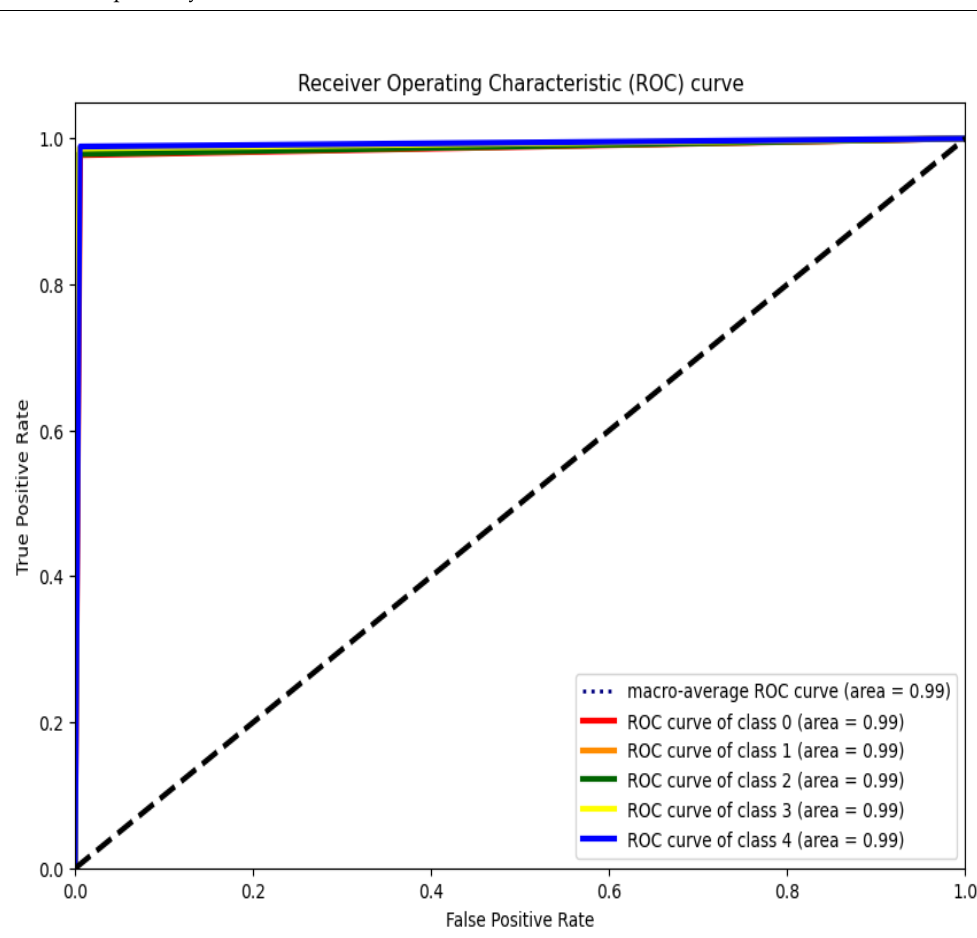
Figure 8. The ROC of the SVM model using five - fold cross - validation.